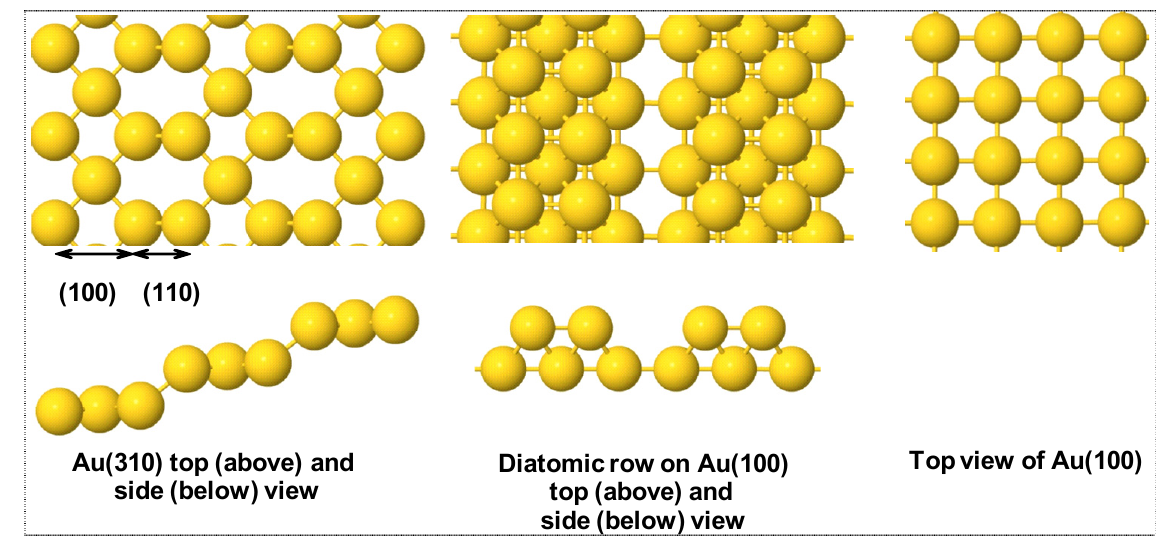
Figure 1. Top and side view of top layer of different Au surfaces used in this study.